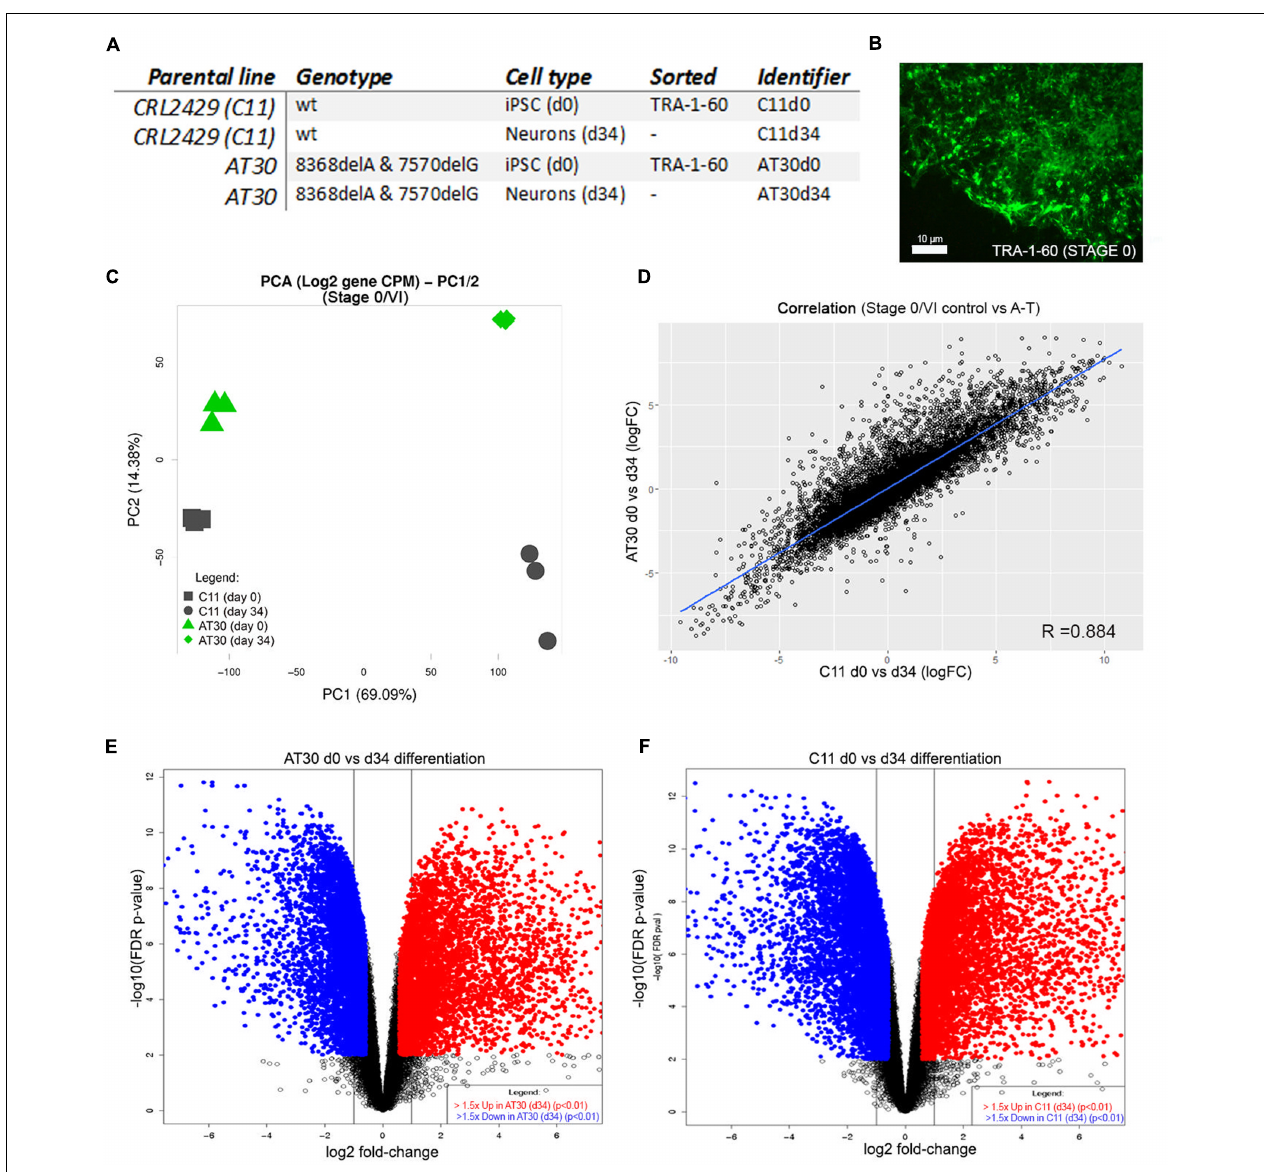
FIGURE 3 | Transcriptomic characterization of differentiated neurons. (A) Table detailing iPSCs selected for RNA sequencing. (B) Representative iPSC colony immunolabelled with antibody to TRA-1-60. Scale bar is 10 µ m. (C) PCA shows tight clustering of experimental replicates. Y -axis shows PC2, X -axis shows PC1. (D) Correlation between samples following differentiation by limma-estimated log-fold change in expression between AT30 d0 vs. d34 and C11 d0 vs. d34. (E,F) Volcano plots show changes in the expression of genes after differentiation ( E = AT30 d0 vs. d34, F = C11 d0 vs. d34). Differentially expressed genes (adj. p -value < 0.01 and logFC > 1.5) are shown as blue/red